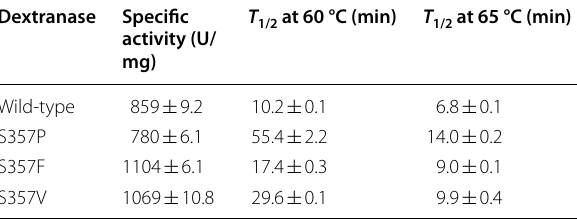
Table 1 Specific activities and half-lives of wild-type and mutant